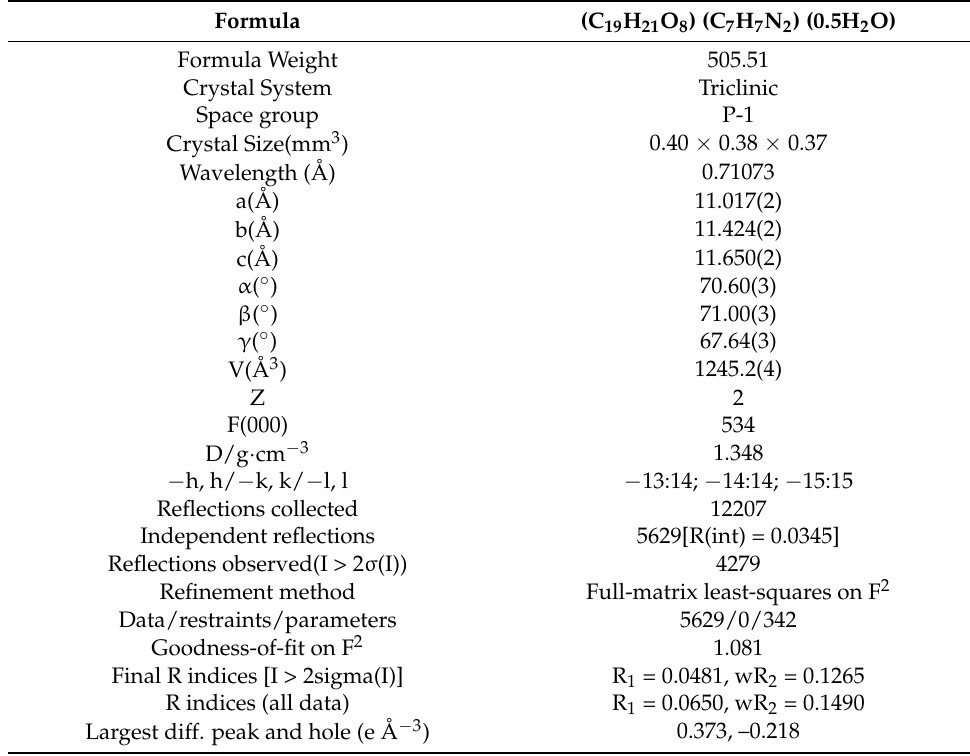
Table 3. Selected crystal data and details of the structure determination for the title